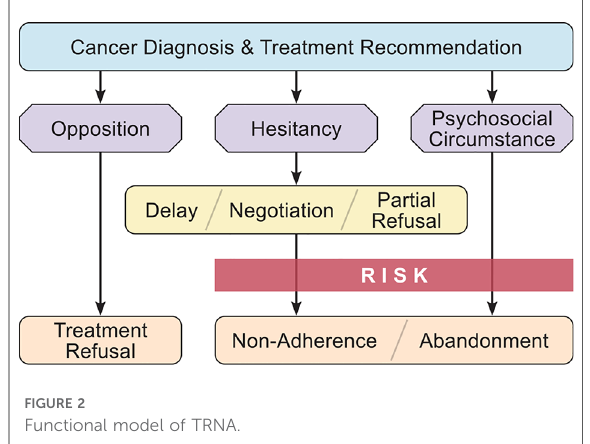
FIGURE 2 Functional model of